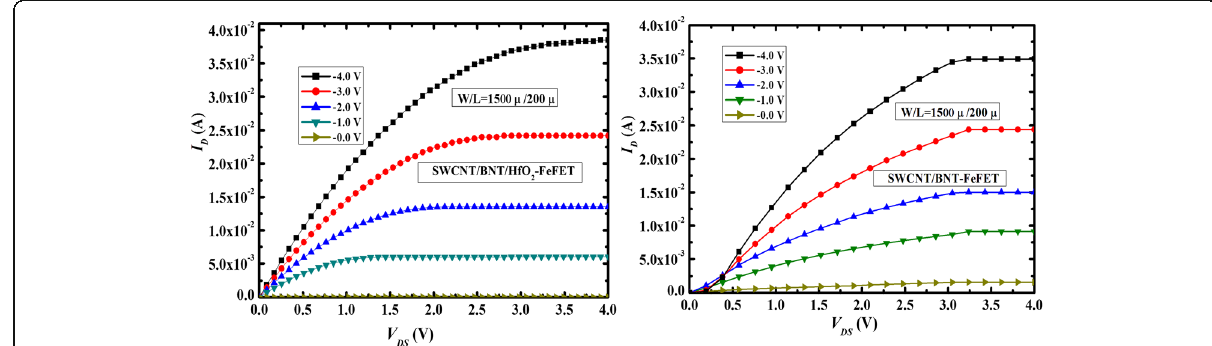
Fig. 3 Output characteristics curves of SWCNT/BNT/HfO 2 -FeFET(letf) and